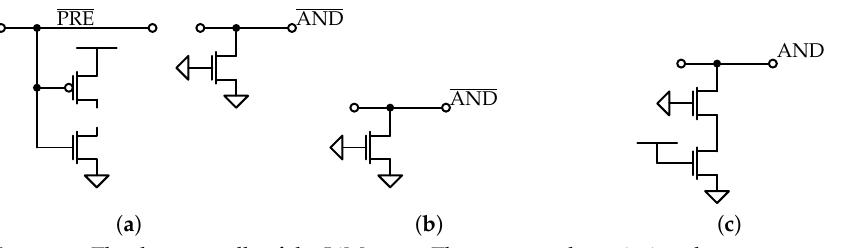
Figure 12. The dummy cells of the LiM array. These are used to mimic a dummy memory row, which is sensed by a special sense amplifier that drives the other ones in order to reduce the overall energy consumption involved in the AND operation, which is performed on the whole array. ( a ) The dynamic AND dummy cell. ( b ) The static AND dummy cell. ( c ) The special-purpose AND dummy